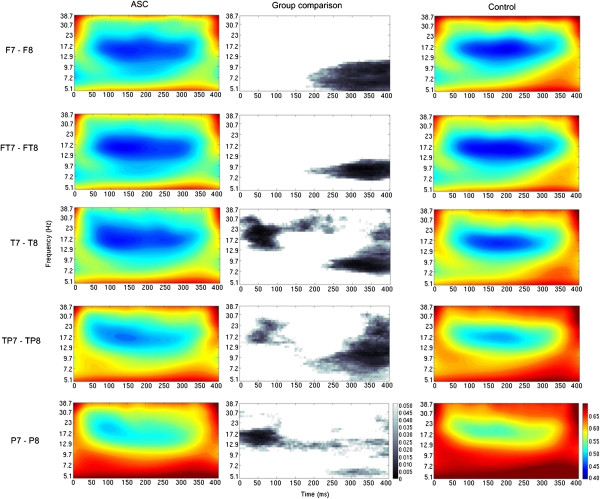
Mann–Whitney group comparison of interhemispheric coherence for the chairs task (uncorrected P-values). The colored graphs represent values of wavelet coherence for the ‘chairs’ task, for every time-frequency point and for each group (ASC: left column, controls: right column) and each pair of electrodes (different rows); areas in blue represent regions of low coherence in the time-frequency spectrum, while areas in red represent regions of high coherence. The graphs in the middle column represent the statistical group comparison for each electrode pair; areas shaded gray represent regions of the time-frequency spectrum where there is a significant decrease of coherence for the ASC group compared to the control group, at Puncorrected <0.05. No areas were found where there was a significant increase in coherence for the ASC group compared to the control group.